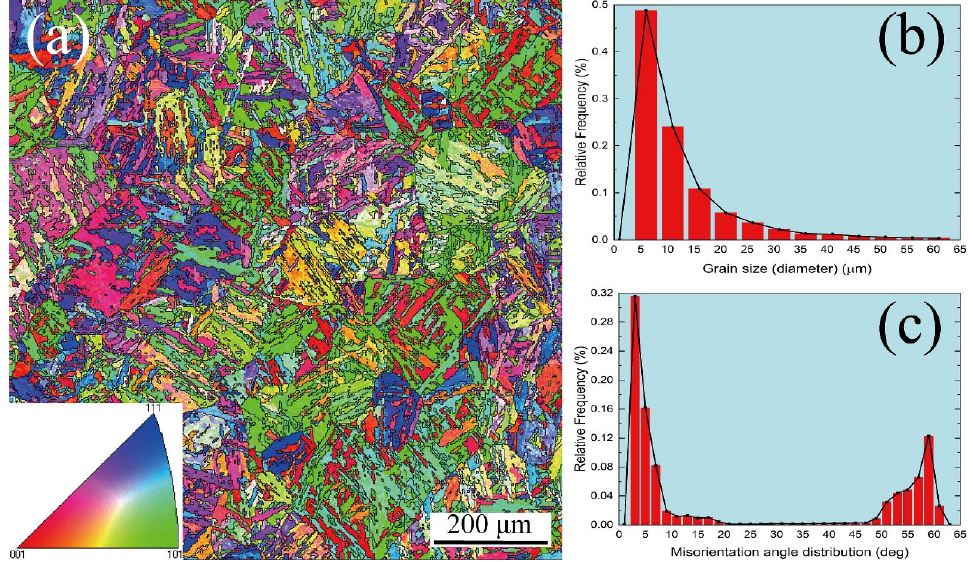
Figure 1. EBSD image of the as ‐ received MarBN steel: ( a ) polo figures; ( b ) grain size distribution; ( c ) misorientation angle distribution.